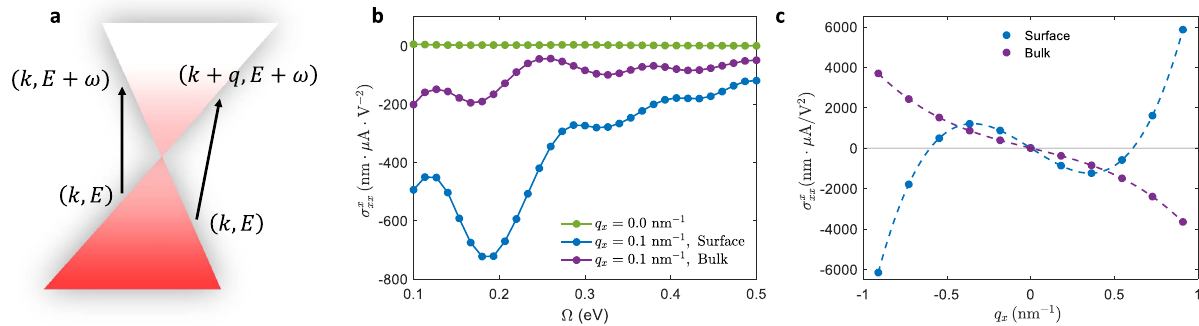
Fig. 4 BPV under inhomogeneous light fi eld. a An illustration of the electron transitions under homogeneous (left arrow) and inhomogeneous (right arrow) fi eld. b BPV conductivity under homogeneous ( q ¼ 0 ) and in inhomogeneous ( q x ≠ 0 ) fi eld. c The relationship between σ x xx ω ¼ 0 : 1 eV ; q x ð Þ and q x for surface (blue curve) and bulk (purple curve) PL. The dashed curves are fi ttings of the solid dots with cubic